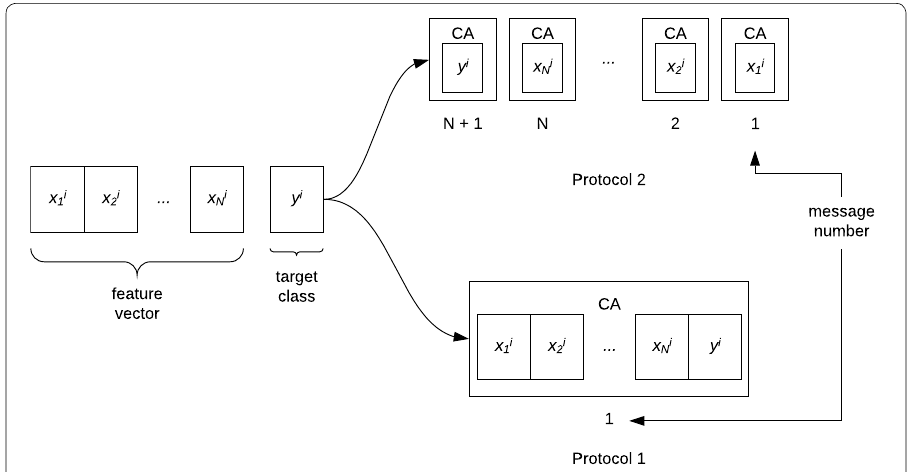
Fig. 2 Messaging protocols. Protocol 2, i.e. single entry versus Protocol 1, i.e. marshaling protocol is presented for data of the i th